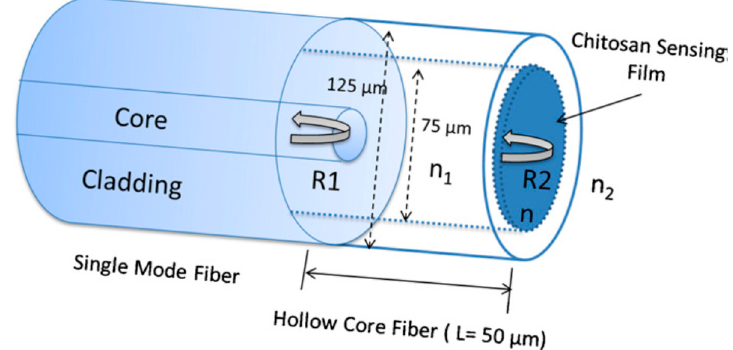
Figure 17. Structures of the proposed sensor based on a Fabry–Pèrot (FP) interferometer coated with chitosan film. Reprinted with permission from [117].